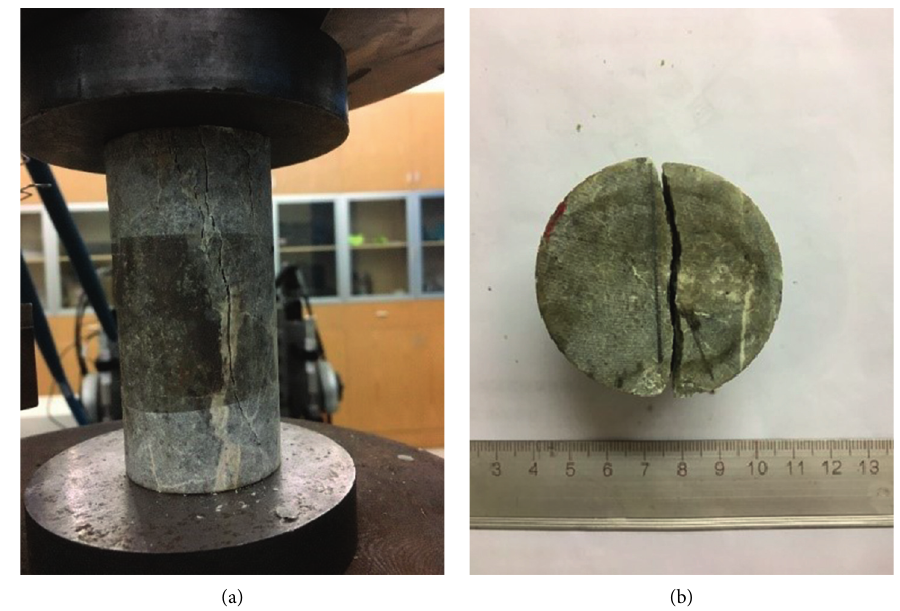
Figure 3: Failure mode of rock under static load test. (a) Front view; (b) top view.